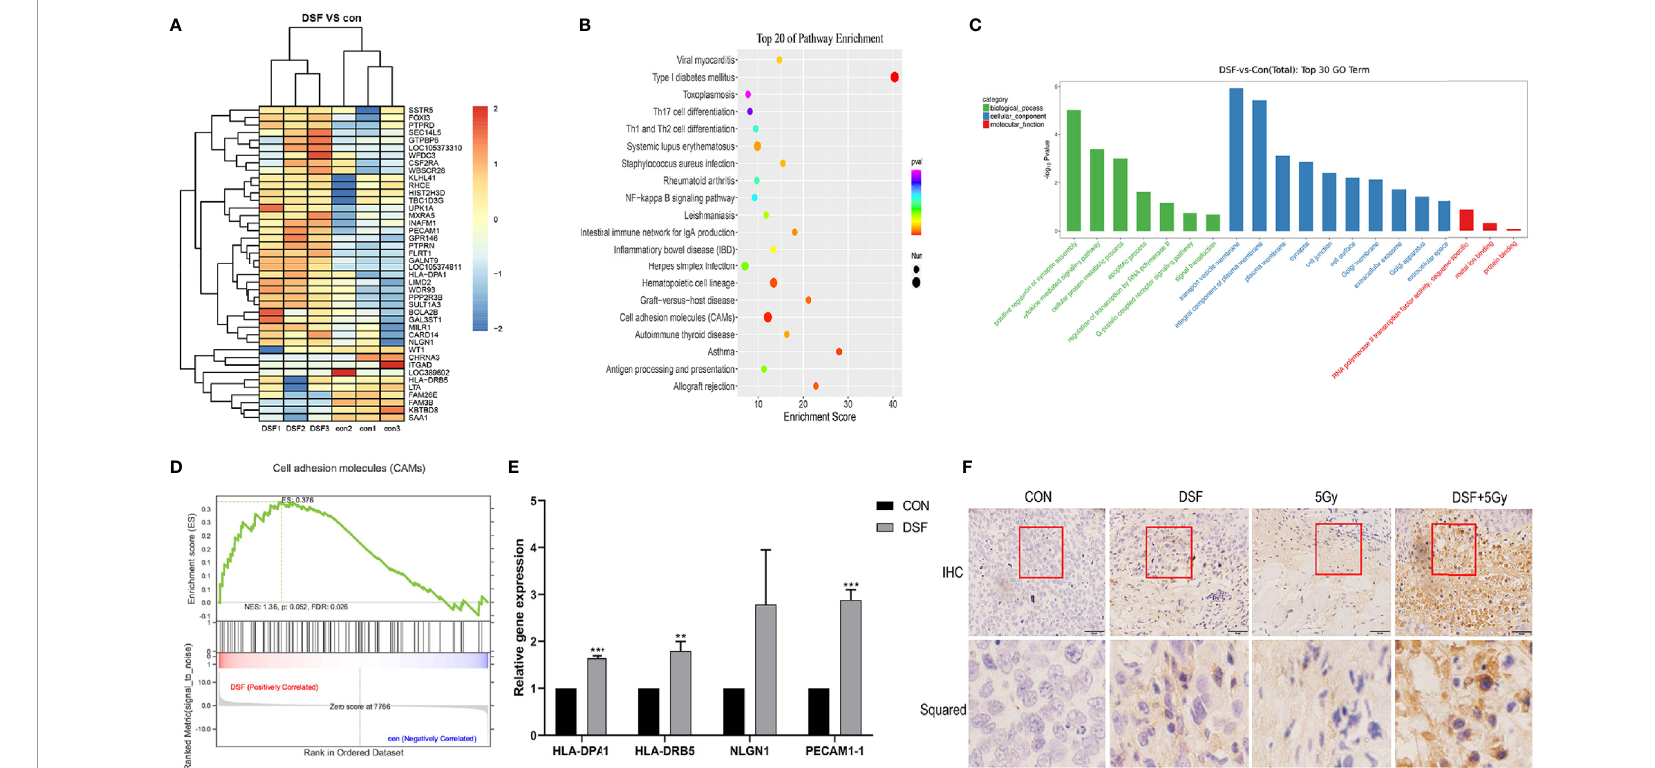
FIGURE 8 | Biological function analysis of DEGs by RNA-seq technology. (A) Heat map illustrating the DEGs in control and DSF-treated PANC-1 cells after 4 Gy X-ray irradiation. Red represents upregulated genes, and blue represents downregulated genes. (B) KEGG analysis of total DEGs. (C) GO analysis of upregulated genes and downregulated genes. (D) GSEA revealed that the genes of PANC-1 cells treated with DSF were mainly enriched in the CAM signaling pathway. (E) Quantitative reverse transcription PCR (qRT – PCR) analysis of upregulated genes in DSF-treated cells. (n=3), **p < 0.01, ***p < 0.001, using one-way ANOVA. (F) Immunohistochemical staining of PACAM-1 in tumor